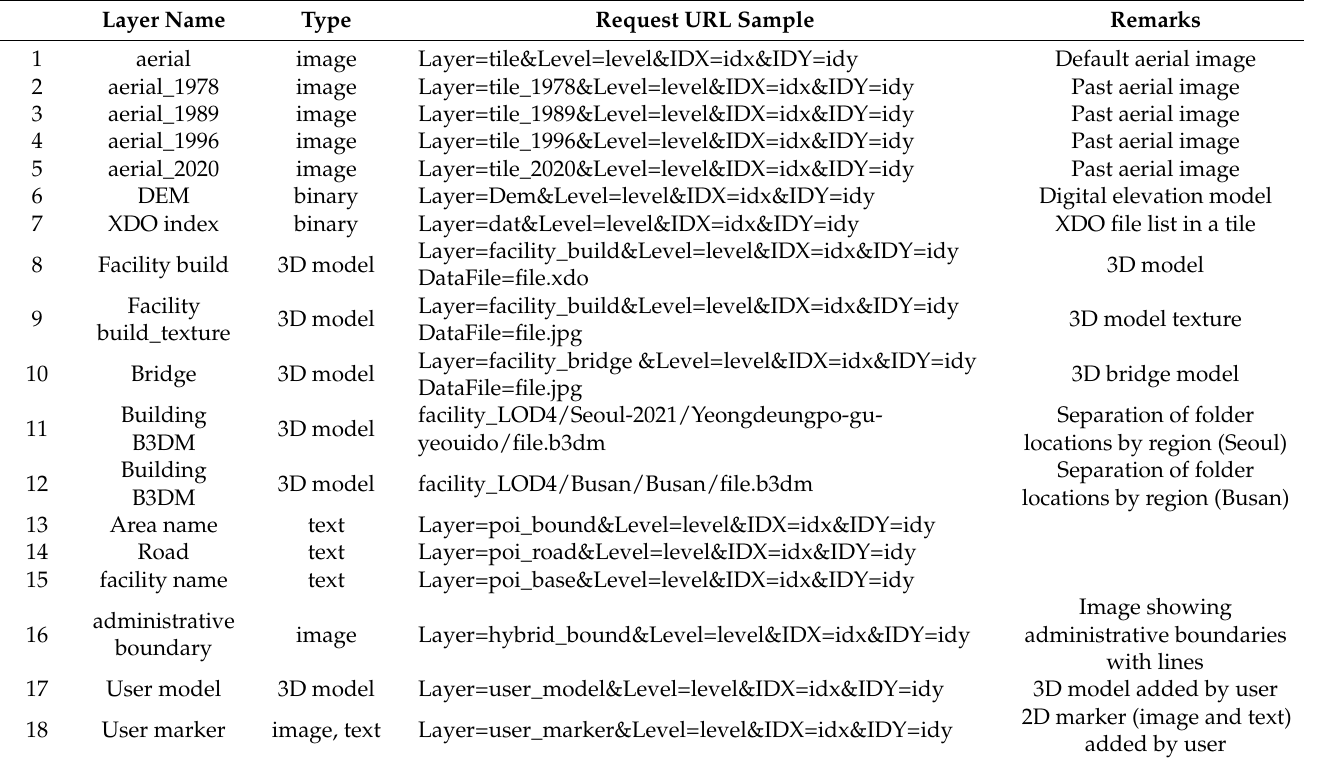
Table 1. Urban geospatial data layer